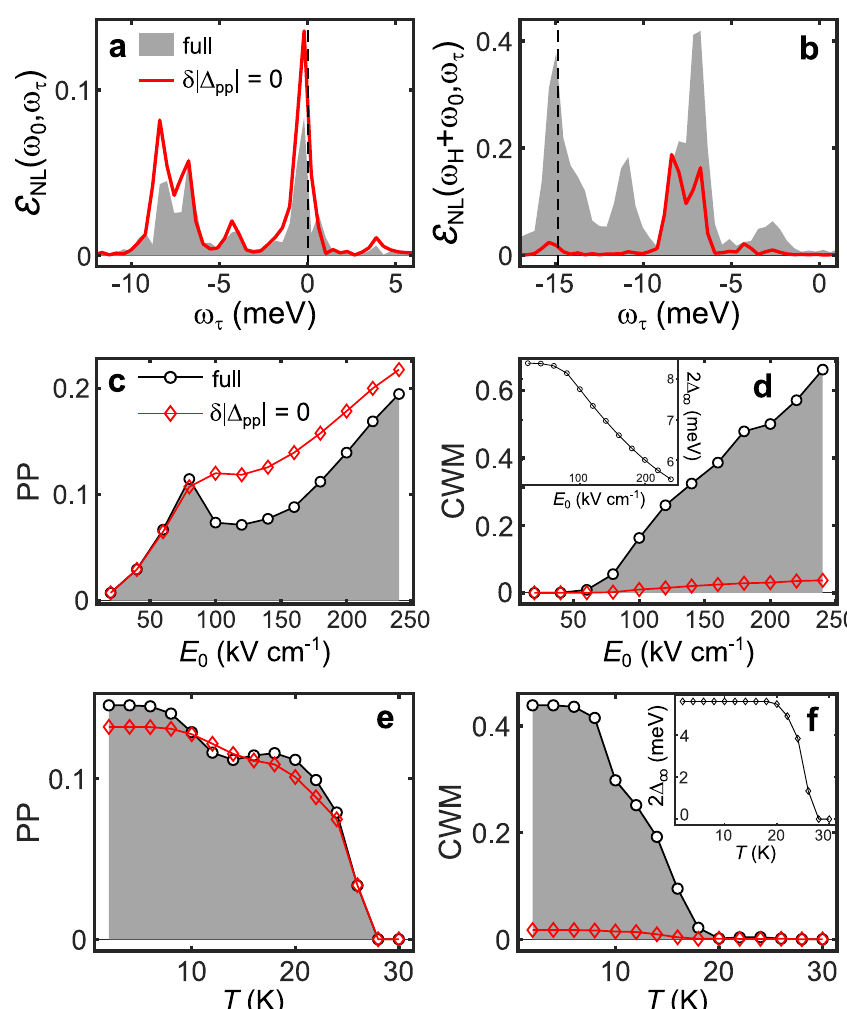
Fig. 3 Pump fi eld and temperature dependences of the different multi-dimensional spectral peaks. a , b Correlated nonlinear signal E NL ð ω t ; ω τ Þ at fi xed ω = ω – h ) and ω = ω + ω – h ) for the full calculation (shaded area) and the calculation t t 0 (magenta dashed line in Fig. 2 e H 0 (black dashed line in Fig. 2 e without pump-probe coherent modulation of the order parameter, δ ∣ Δ pp ( t , τ ) ∣ = 0 (solid line). Vertical dashed lines indicate the pump-probe ( a ) and correlated wave-mixing ( b ) signals. c , d Pump-probe (PP) and correlated wave mixing (CWM) signals as a function of pump fi eld strength E 0 . The result of the full calculation (shaded area) is compared with the calculation where δ ∣ Δ pp ∣ = 0 (solid line). With increasing pump fi eld, δ ∣ Δ pp ∣ ≠ 0 is responsible for the entire correlated wave mixing signal, but only slightly modi fi es the pump-probe signal. Inset d : Pump- fi eld dependence of the Higgs mode energy 2 Δ ∞ (non-equilibrium state order parameter). e , f Temperature dependence of the pump-probe and correlated wave-mixing peaks for the full calculation (shaded area) and the calculation with δ ∣ Δ pp ∣ = 0 (solid line) up to the transition temperature T c . The pump-probe signal follows the T- dependence of the non-equilibrium order parameter 2 Δ ∞ (inset f ) and is only slightly affected by δ ∣ Δ pp ∣ . In contrast, the correlated wave mixing signal is dominated by the time-dependence of δ ∣ Δ pp ∣ and, for this simple one-band BCS model, is suppressed well below T c . Inset f Temperature dependence of the non-equilibrium order parameter 2 Δ ∞ ( T ). This differs distinctly from the T -dependence of the correlated wave mixing peak in f , unlike for the pump-probe peak in e